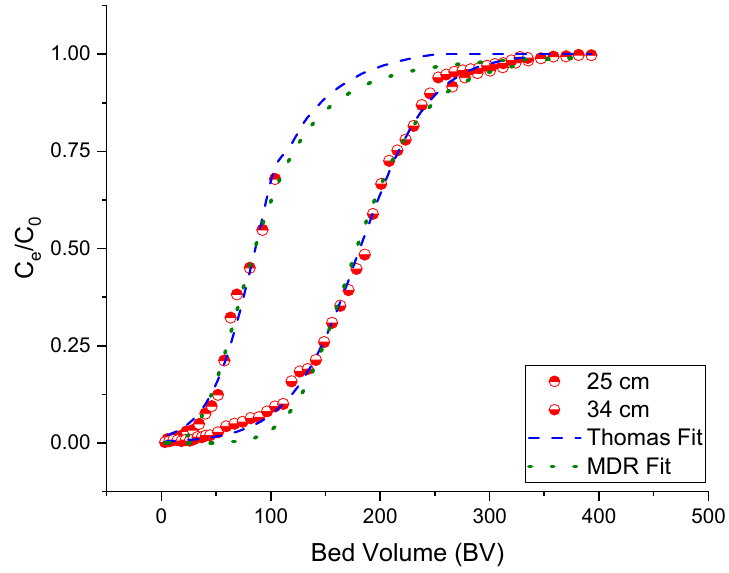
Figure 5. Agitated Tubular Reactor (ATR) breakthrough data, along with Thomas and Modified Dose Response (MDR) model fits, for strontium at a 100 ppm concentration and residence times of 15 min for two different bed lengths (25 cm and 34 cm).